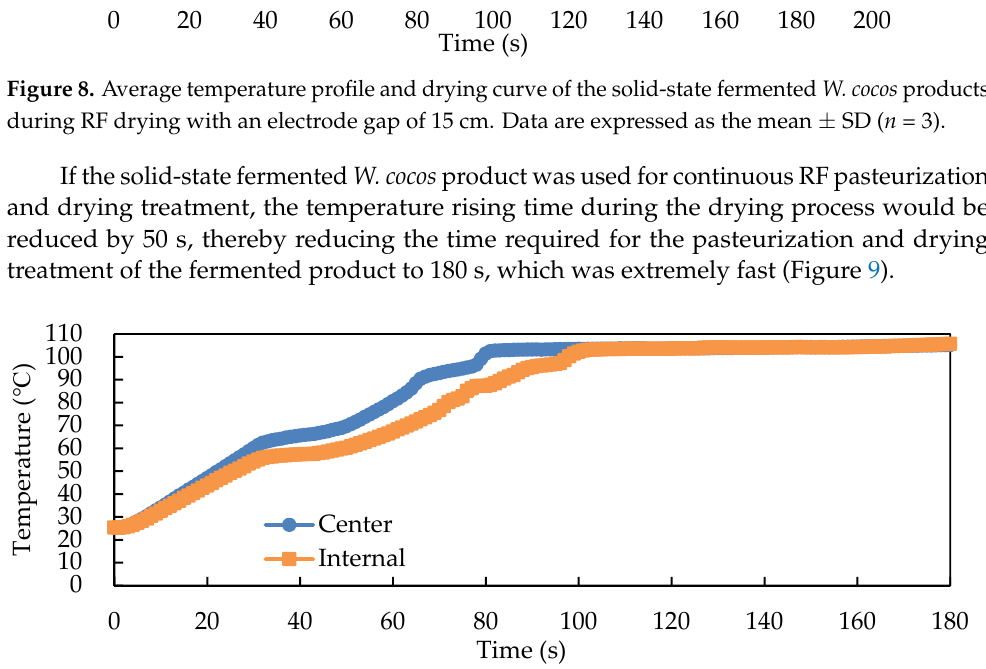
Figure 9. Center and internal temperature profiles of the solid-state fermented W. cocos products during continuous RF drying with an electrode gap of 15 cm, pasteurization of 30 s, and drying of 150 s.